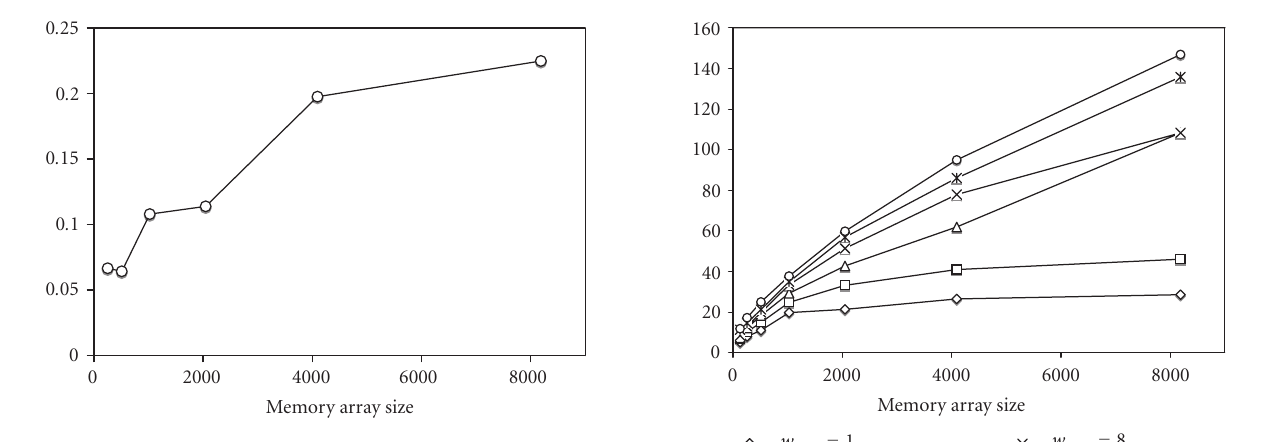
Figure 7: Impact on memory energy when increasing memory ar- ray size.